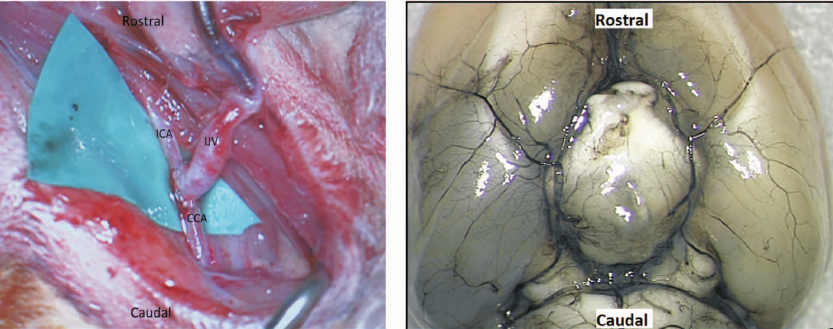
Figure 1. Left panel shows an AV fistula construction by anastomosing end-to-side left external jugular vein to common carotid artery. Post surgically, a reversed blood flow to the jugular vein was achieved. The vein was engorged by a higher blood pressure generated from the heart. Right panel shows the circle of Willis after fixation. Arteries were filled with TMD black dye by injecting the dye through punctuating the left ventricle of the heart after flushing the blood out completely with PBS. IJV: Internal jugular vein. ICA: Internal carotid artery. CCA: Common carotid artery.